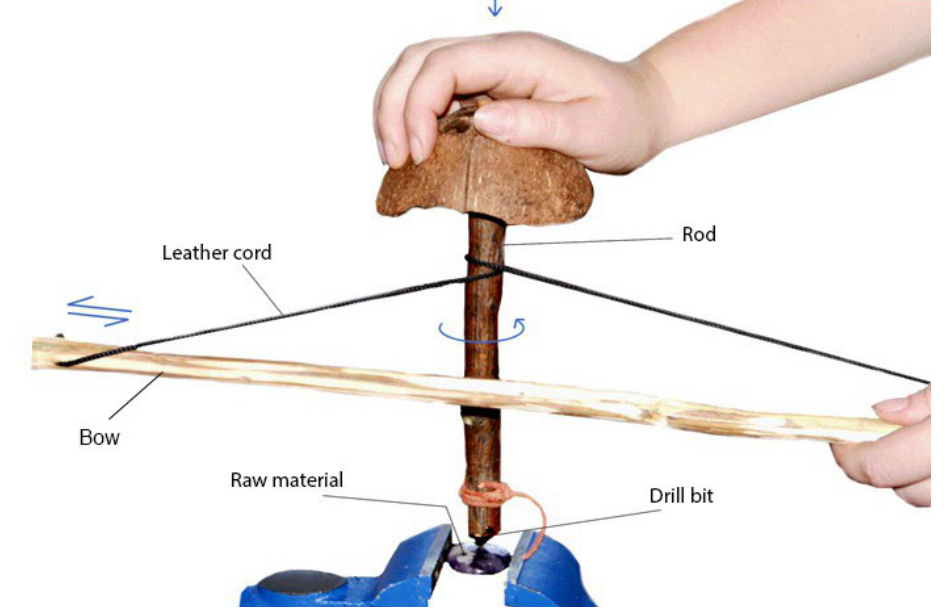
Figure 6: Experimental bow drill device used in this